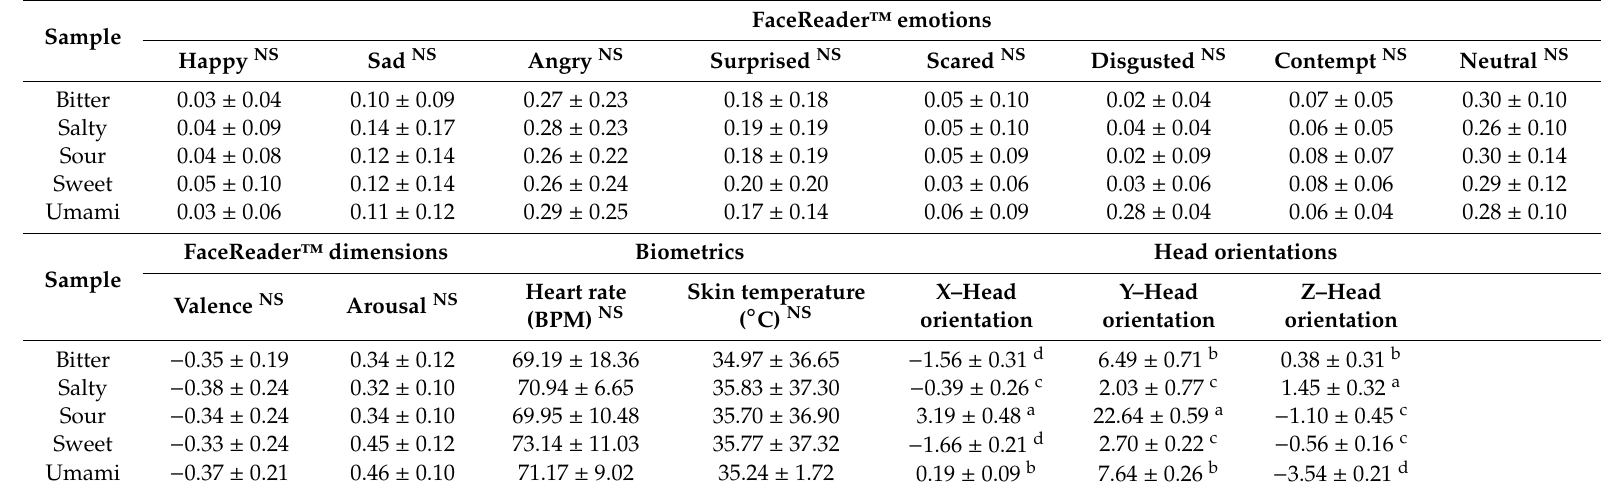
Table 5. Mean values for unconscious responses of chocolate